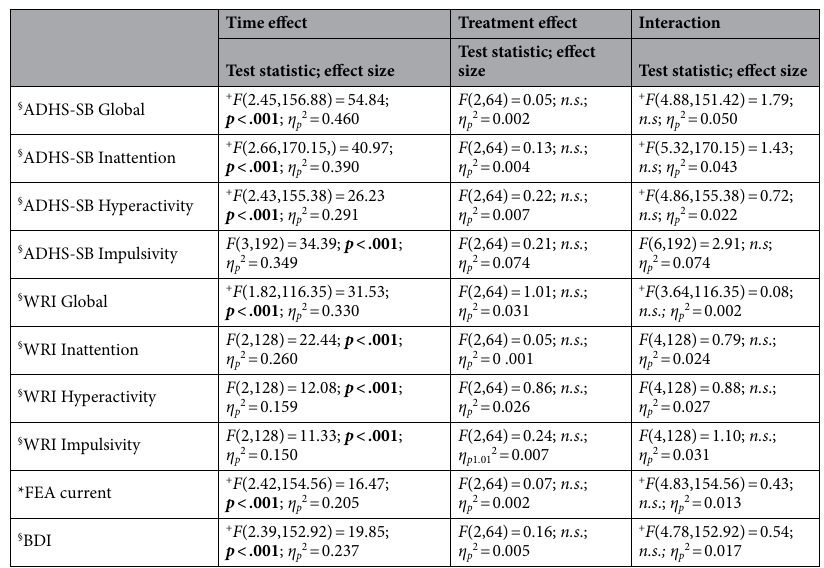
Table 2. Symptom ratings before feedback training, after half of the sessions and after feedback training for each group. Note. ADHS‑SB = German ADHD self-rating scale for symptoms in adulthood 35,36 ; BDI = Beck- Depression Inventory 47 ; EMG = Electromyography; d Cohen = , effect size Cohen’s d; FU = Follow-up; n.s . = not significant; SCP = Slow Cortical Potential; SD = Standard Deviation; WRI = Wender-Reimherr-Interview 35,36 : assessment at pre-, post- and follow-up assessment. + Greenhouse–Geisser corrected. § Information missing for 2 participants at follow-up. *Information missing for 15 participants at pre-, for 32 participants (46.3%) at mid-, for 37 participants (53.7%) at post-training and for 43 participants (62.7%) at